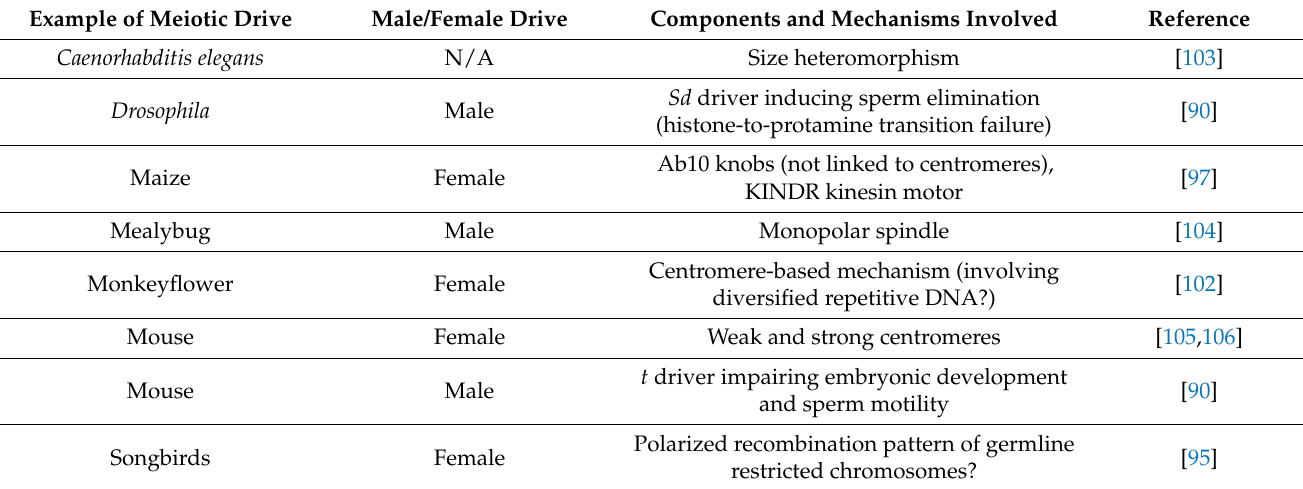
Table 1. Selected known examples of the meiotic drive, including their